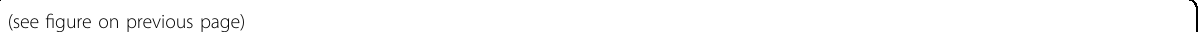
Fig. 4 δ -secretase overexpression triggers cognitive dysfunctions, associated with synapse and dendritic spine loss in hAPP/hMAPT mice. A Representative electron microscopy images of the synaptic structures at the CA1 region at 3 months after the AAV-AEP virus injection. Arrows indicated the synapses (left, scale bar: 2 μ m). Quantitative analysis of the synaptic density in each group (right, Mean±SEM, n = 6 mice for each group, two-way ANOVA with Bonferroni multiple-comparisons test. * as compared to WT mice + AAV-Control virus; # as compared to the WT mice + AAV- AEP virus; $ as compared to AAV-Control virus in same mouse strain). B Golgi staining showed the dendritic spines from the apical dendritic layer of the CA1 region. (Left, Scale bar: 5 μ m). Quantitative analysis of the spine density. (Right, Mean±SEM, n = 6 mice for each group, two-way ANOVA with Bonferroni multiple-comparisons test. * as compared to WT mice + AAV-Control virus; # as compared to the WT mice + AAV-AEP virus; $ as compared to AAV-Control virus in same mouse strain). C Gallyas silver staining for senile plaque and NFT in the hippocampus (Left. Scale bar: 50 μ m). Quantitative analysis of the percentage of signal intensity (right, Mean±SEM, n = 6 mice for each group, two-way ANOVA with Bonferroni multiple- comparisons test. * as compared to WT mice + AAV-Control virus; # as compared to the WT mice + AAV-AEP virus; $ as compared to AAV-Control virus in same mouse strain). D Morris water maze analysis as the percentage of time spent in the target quadrant in the probe trial (left) and the latency time (right, AUC: area under the curve) to the platform in the training days. (Mean ± SEM, n = 12 mice for each group, unpaired t-test, two- tailed, * as compared to hAPP/hMAPT mice + AAV-Control virus). E Fear conditioning tests. Contextual (left) and cued (right) fear conditioning were time-dependently impaired in mice after the virus injection. (Mean ± SEM, n = 12 mice for each group, unpaired t-test, two-tailed, * as compared to hAPP/hMAPT mice + AAV-Control